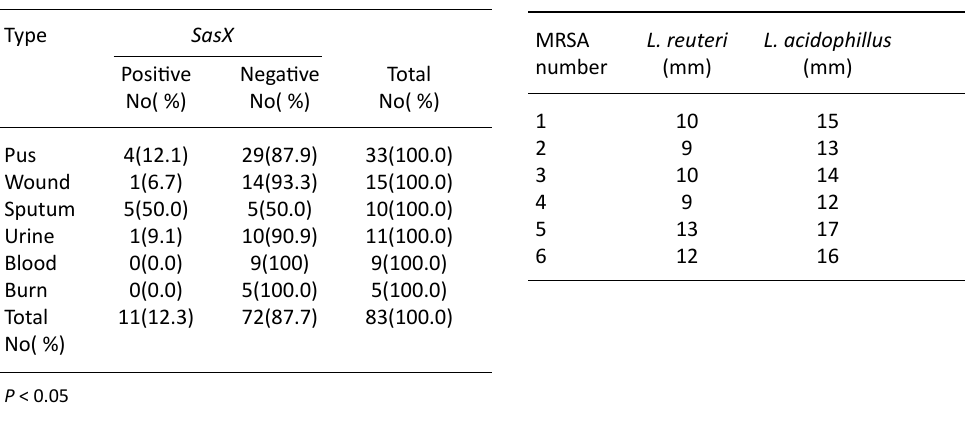
Fig. 5. Agarose gel electrophoresis image that shown the PCR product of SasX gene in S. aureus isolates. Where M: Marker (100-2000bp), lane (1-10) some positive PCR amplification at (304bp) PCR product size. Table 6. Prevalence of SasX gene in different samples Table 7. Inhibitory effect of Lactobacillus spp . of S. aureus